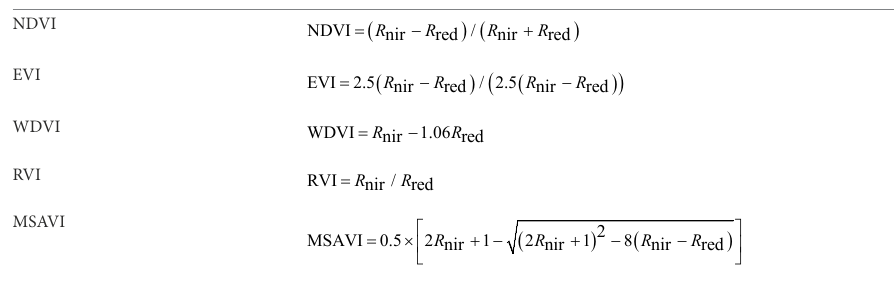
TABLE 1 Vegetation indices and calculation formulas. Name of vegetation